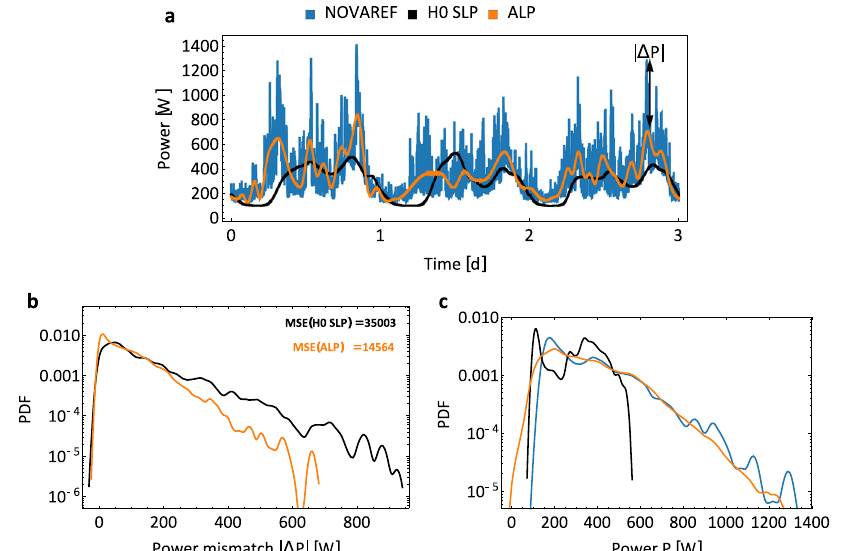
Fig. 6 Synthetic power demand in agreement with empirical data. a We display a brief trajectory of the real (blue), H0 SLP (black) and the new ALP (orange). The ALP curve overall keeps closer to the real consumption values than the H0 SLP does. b The histogram of the power mismatch Δ P = ∣ P (real) − P (model) ∣ shows higher deviations of the demand for the H0 SLP compared to the ALP. We also report the mean-squared error (MSE) of the H0 SLP and the ALP. c Combining the trend extraction via EMD to obtain the ALP and the superstatistical model for demand fl uctuations (DLP) approximates the real consumption histogram very well, in particular for large consumption values. All trajectories use the same time stamps, starting 15 min past midnight on 15th of April of the NOVAREF data from test set. The histograms return almost identical results for other